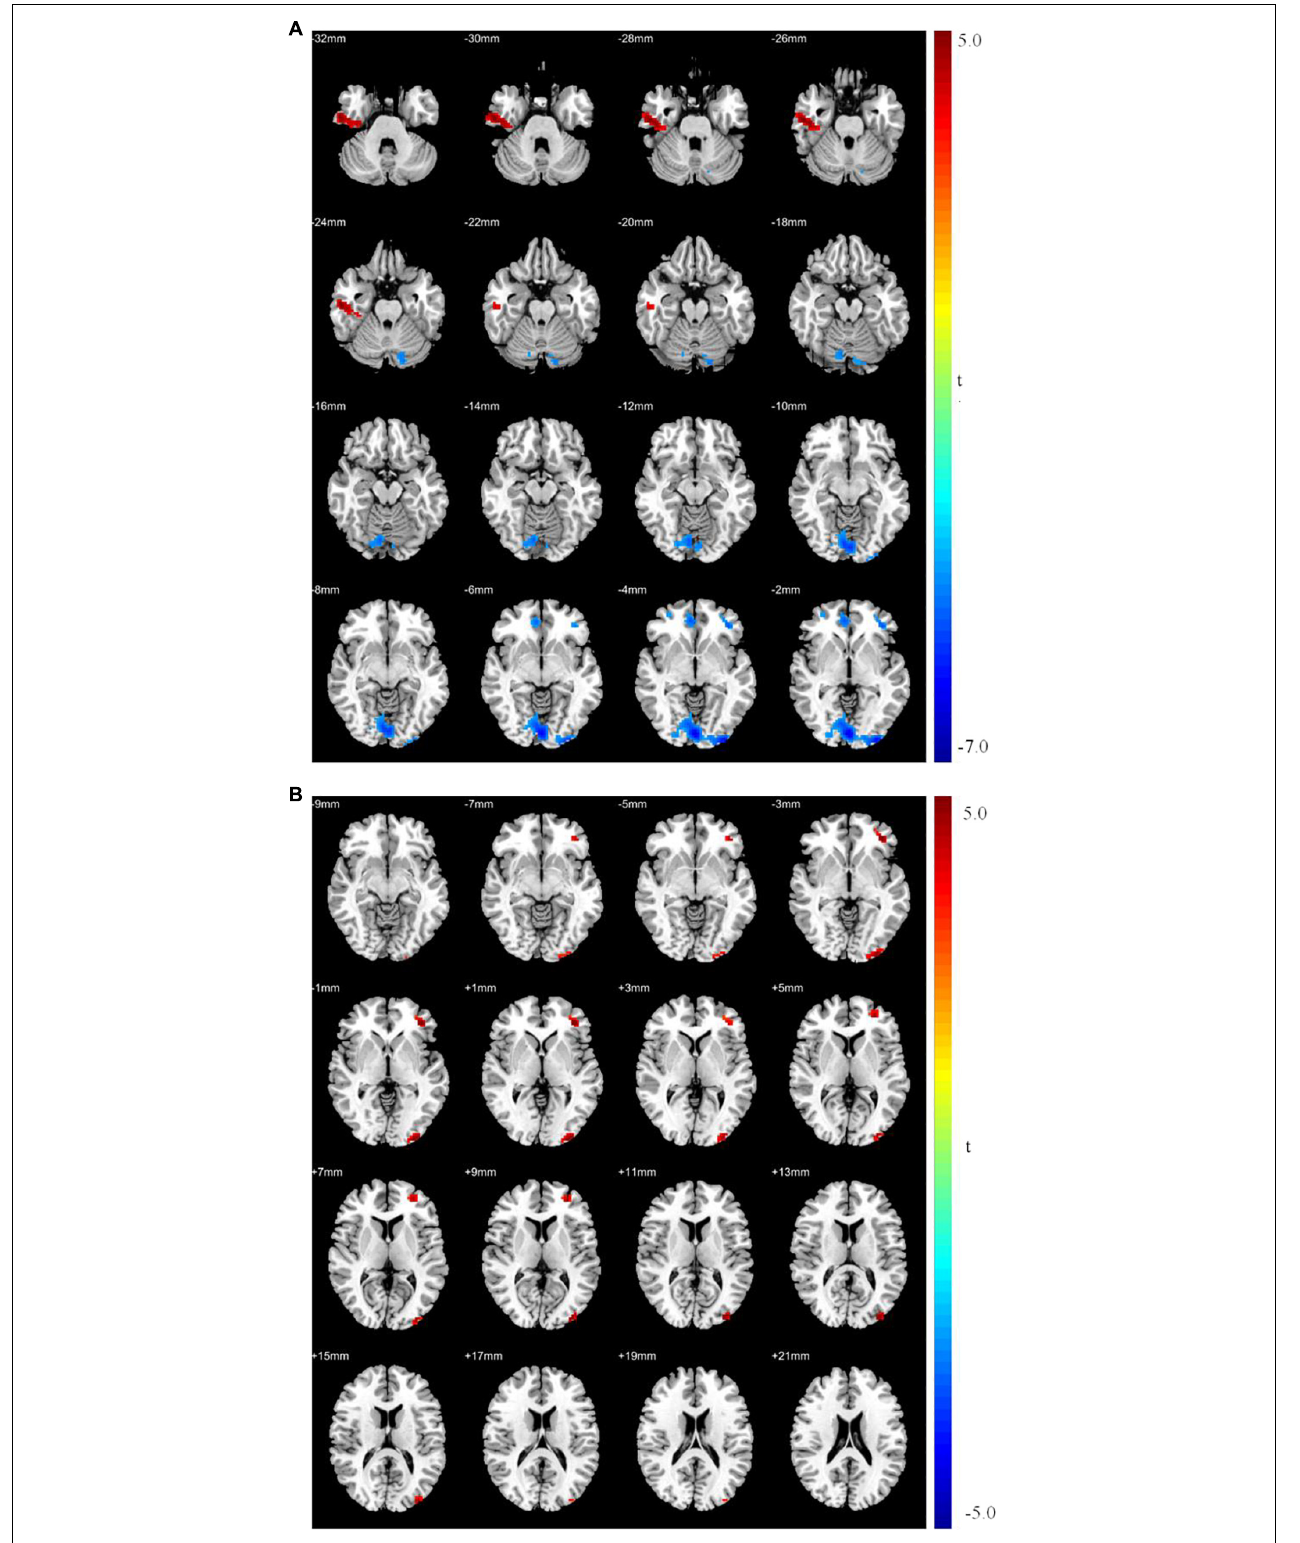
FIGURE 2 | (A) Brain regions showing significant differences of regional homogeneity (ReHo) between MDD and healthy controls. (B) Brain regions showing significant differences of ReHo between pre- and post-rTMS. The warm color denoted the region where ReHo is higher, and the cool color denotes the region where ReHo is